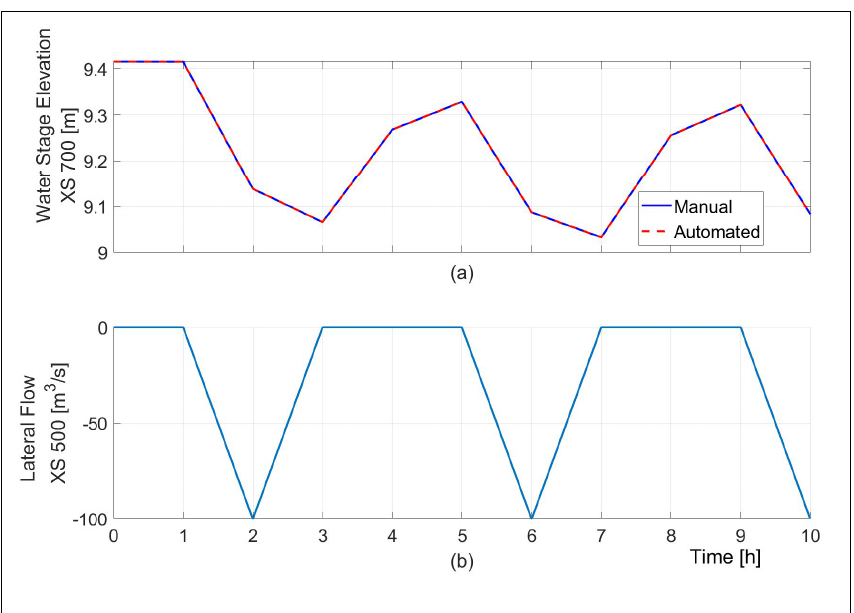
Figure 6. Rectangular canal— scenario2 . ( a ) WSE at XS 700. ( b ) Lateral inflow hydrograph applied at XS